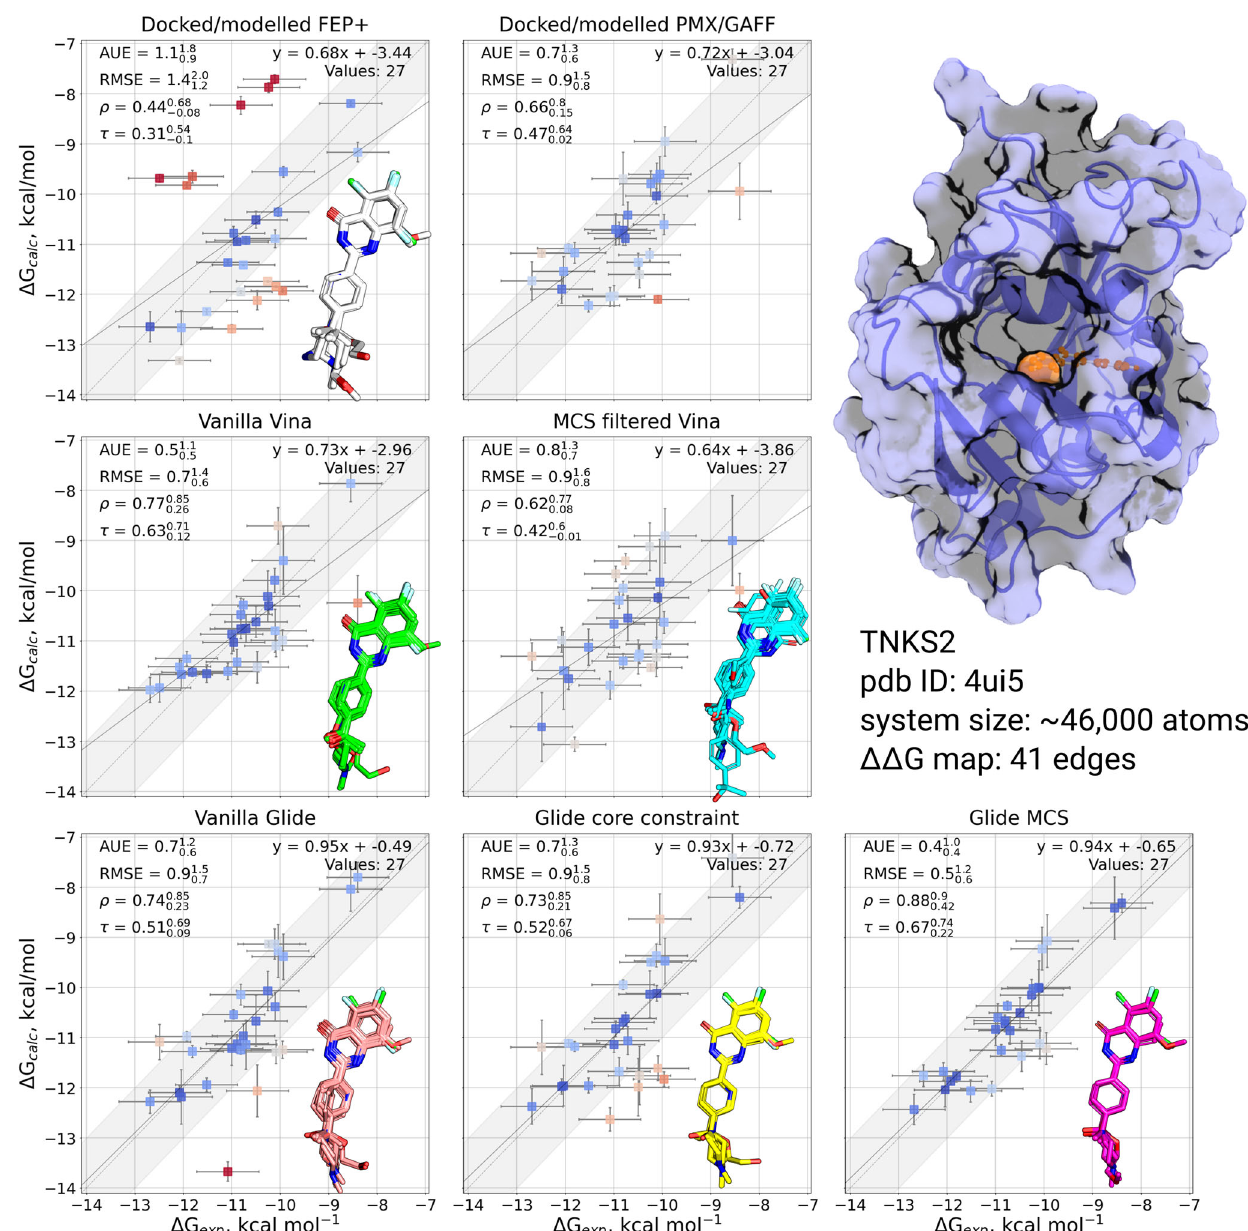
Fig. 3 Comparison of experimentally measured and calculated binding af fi nities for TNKS2 protein-ligand system. The simulations were initialized with different starting structures (docked/modelled or docked only). The data in the panel Docked/modelled FEP + are from Schindler et al. 4 . The data in the panel Docked/modelled PMX/GAFF are from Gapsys et al. 13 . Overlays of starting ligand poses are inset into the corresponding plot. Experimental errors are taken from the original publication, whilst prediction errors correspond to the standard error over 3 simulation replicas also taking into account the bootstrapped uncertainty of individual free energy estimates. The shaded grey region corresponds to a 1 kcal mol − 1 deviation from experiment, and the solid line is a linear fi t through the data. The crystal structure with a bound ligand highlighted in orange is shown in the top